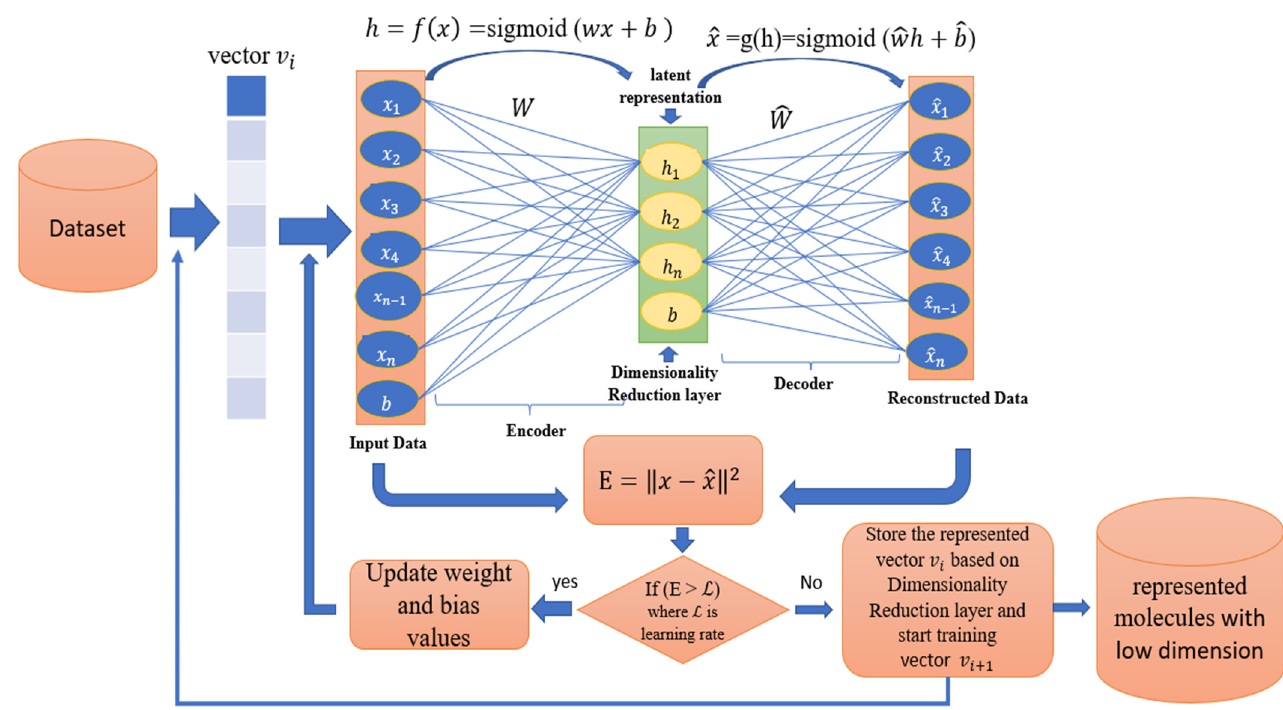
Figure 3. Autoencoder framework for molecular dimensionality reduction.